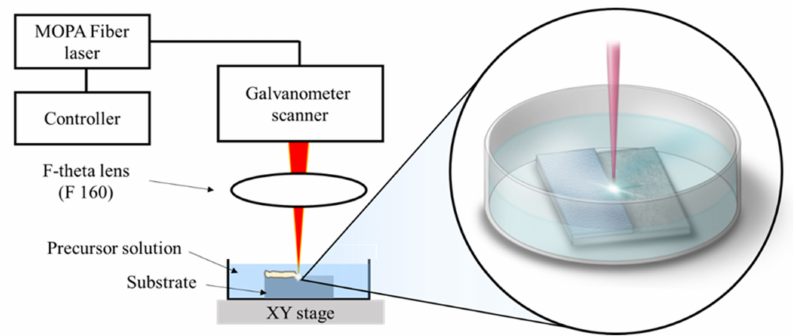
Figure 1. Illustration of laser-induced single-step coating (LISSC) in the precursor solution. A 1 M solution of yttrium nitrate hexahydrate (Y(NO 3 ) 3 6H 2 O; 237957,